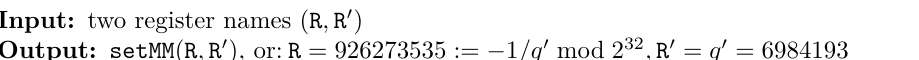
Algorithm 12 Convolution modulo x 3 − 1 with Montgomery